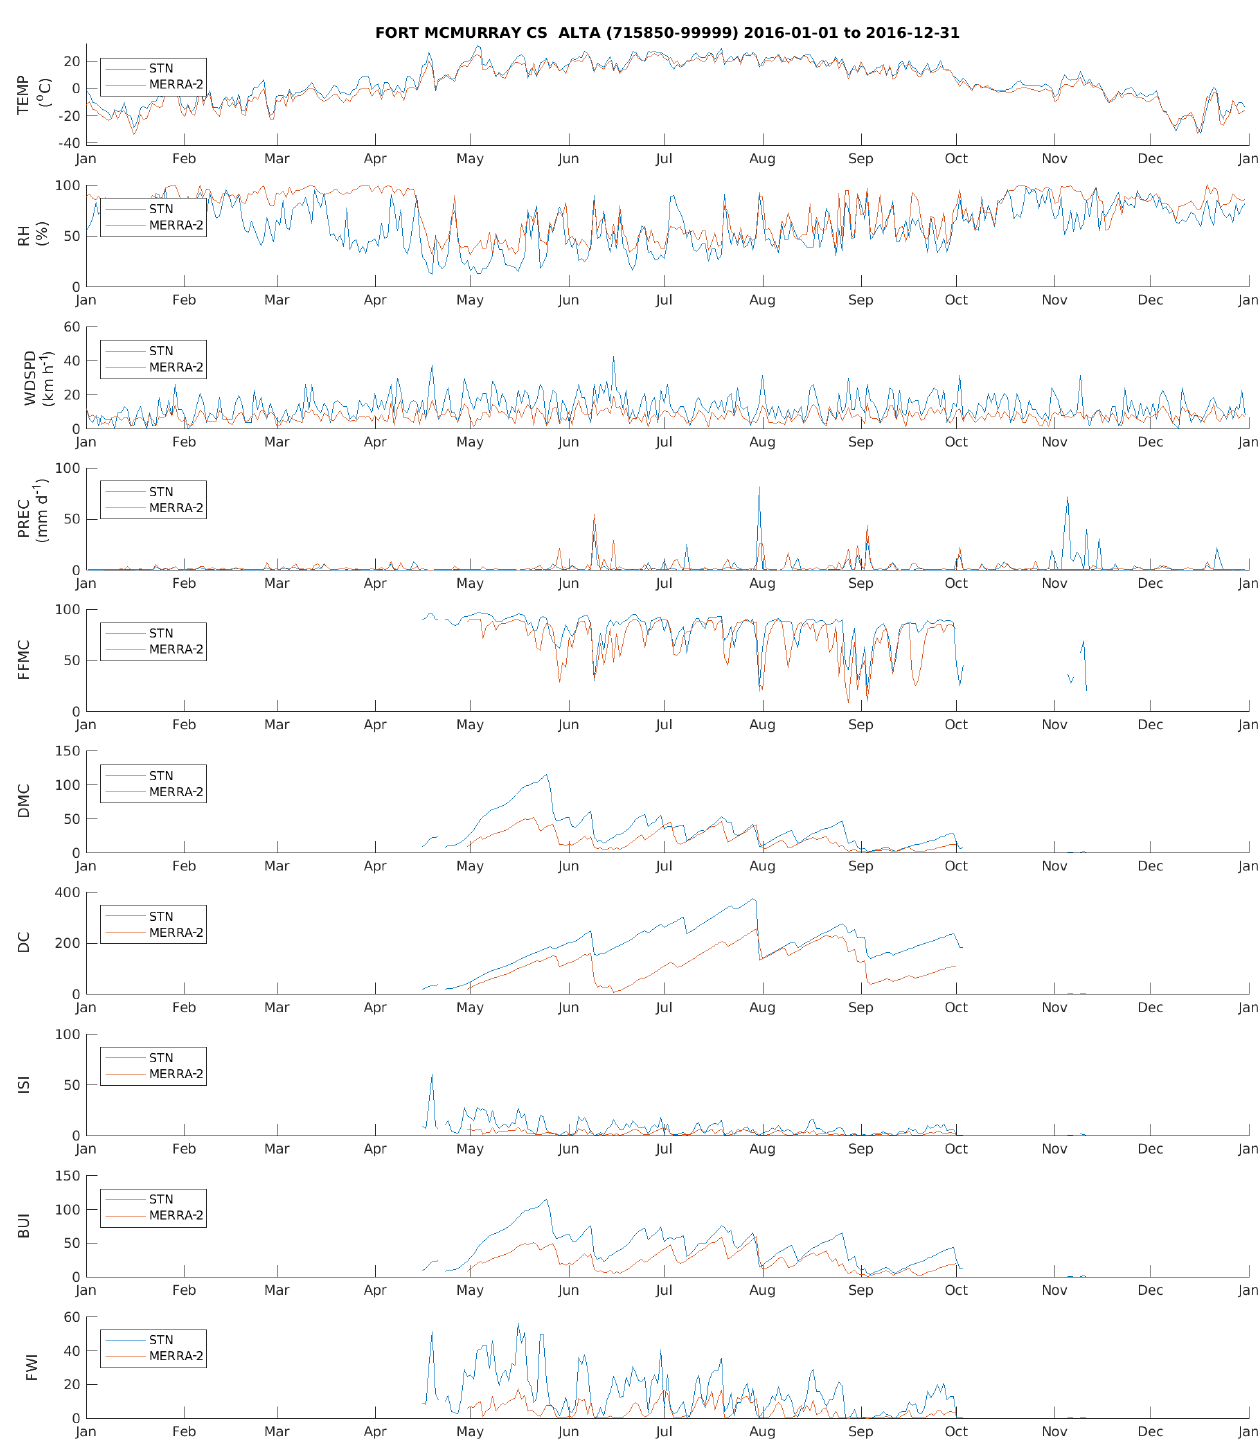
Figure 2. Daily weather input and FWI System component values for Ft. McMurray, Alberta, Canada (WMO ID 715850, WBAN 99999; 56.65 ◦ N, 111.22 ◦ W) for